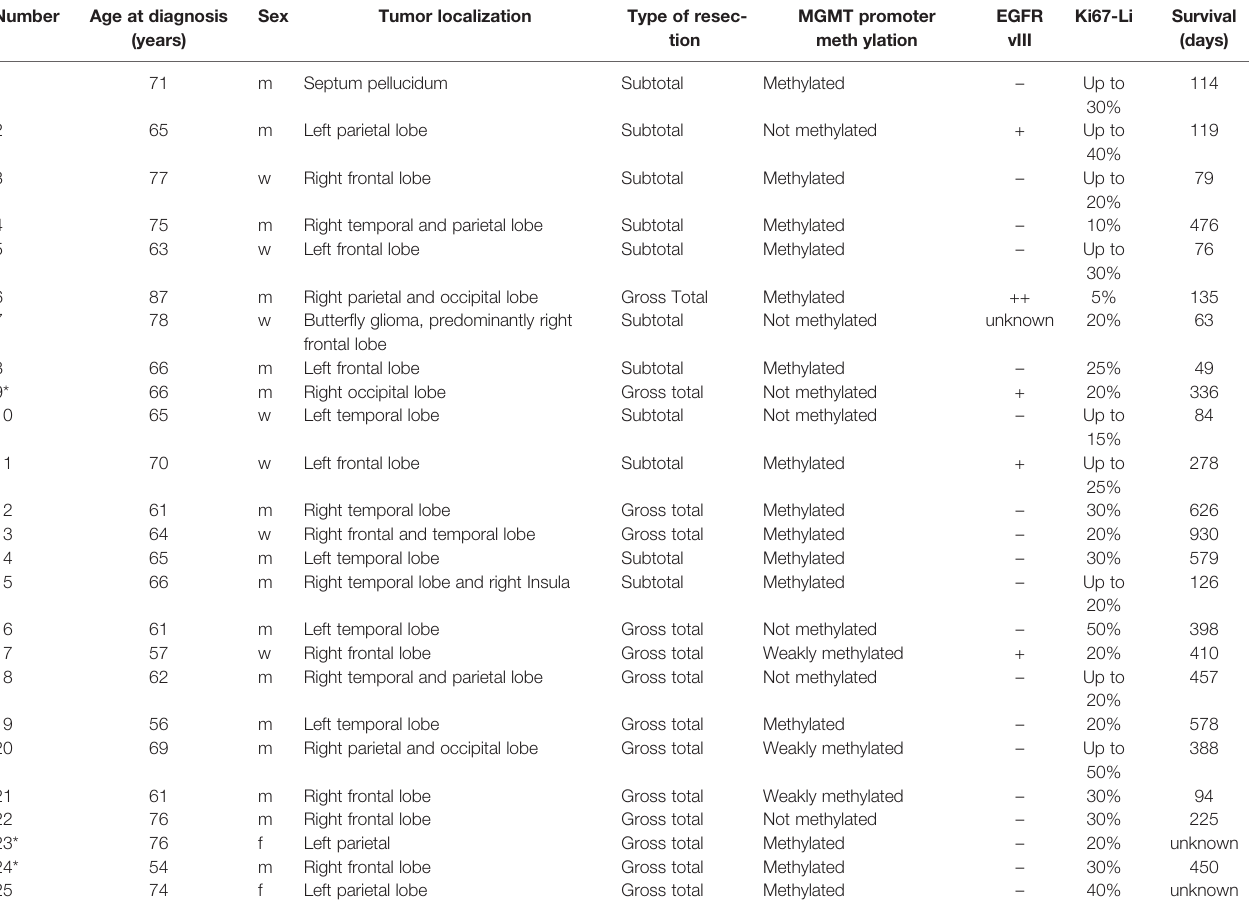
TABLE 1 | Clinical data on patient included tumor tissue samples showed isocitrate dehydrogenase (IDH) wild-type